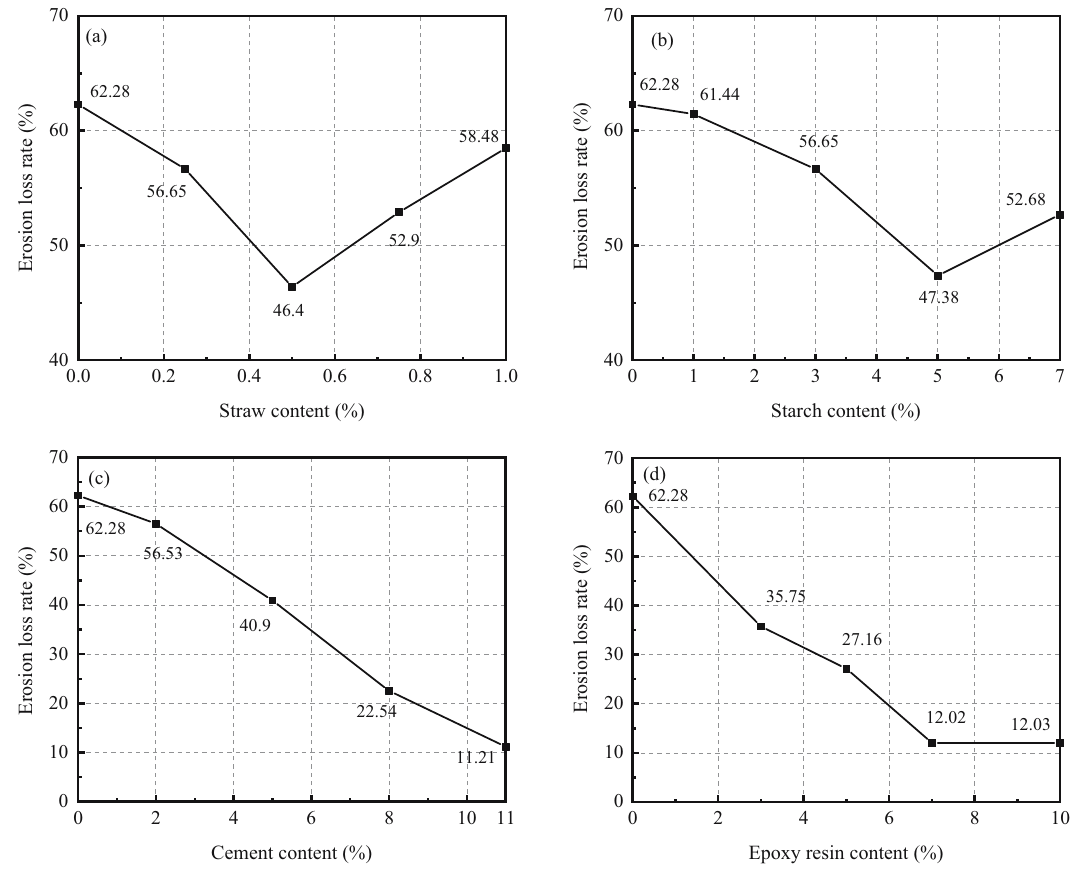
Figure 18: Erosion loss rate of di ff erent materials: ( a ) straw; ( b ) starch; ( c ) cement; and ( d ) epoxy